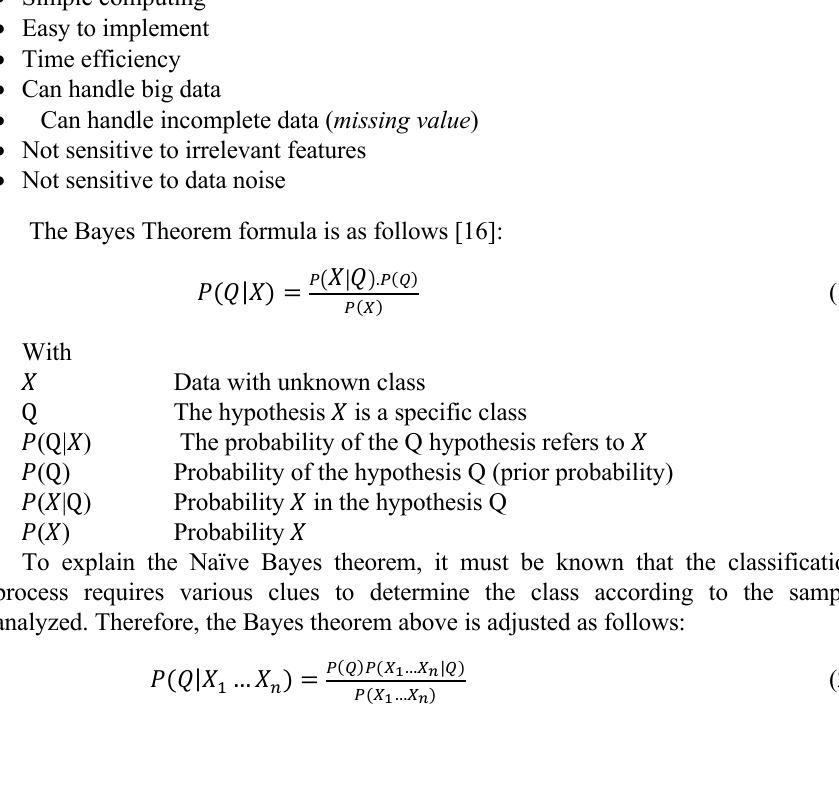
Short Paper —Naïve Bayes Classifier for Journal Quartile